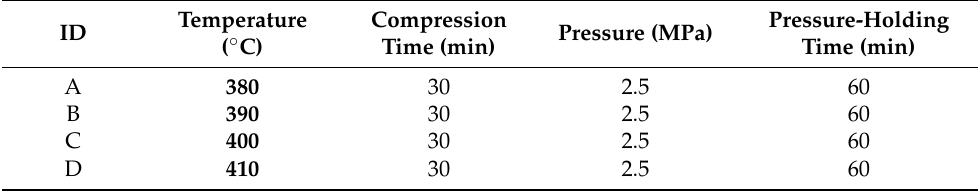
Table 1. Process parameters for different hot compression temperature scenarios.